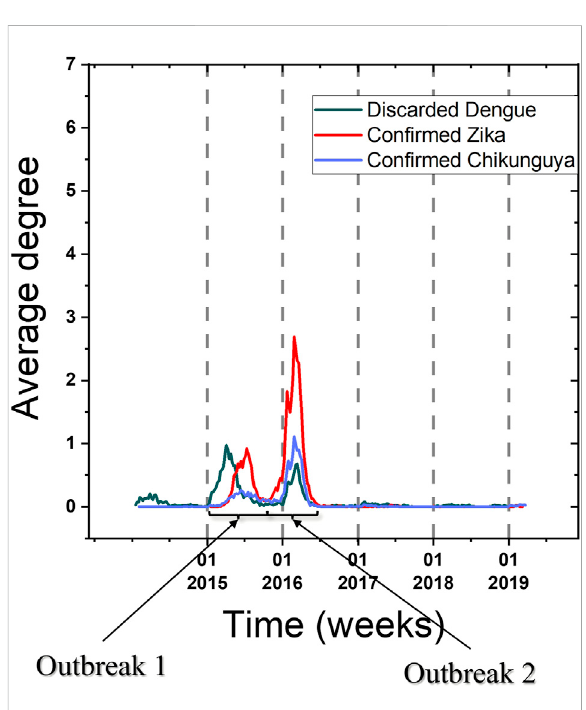
FIGURE 10 Time series of the average degree of the networks of discarded cases of dengue and con fi rmed cases of Zika and chikungunya. The vertical grid lines highlight the beginning of a new